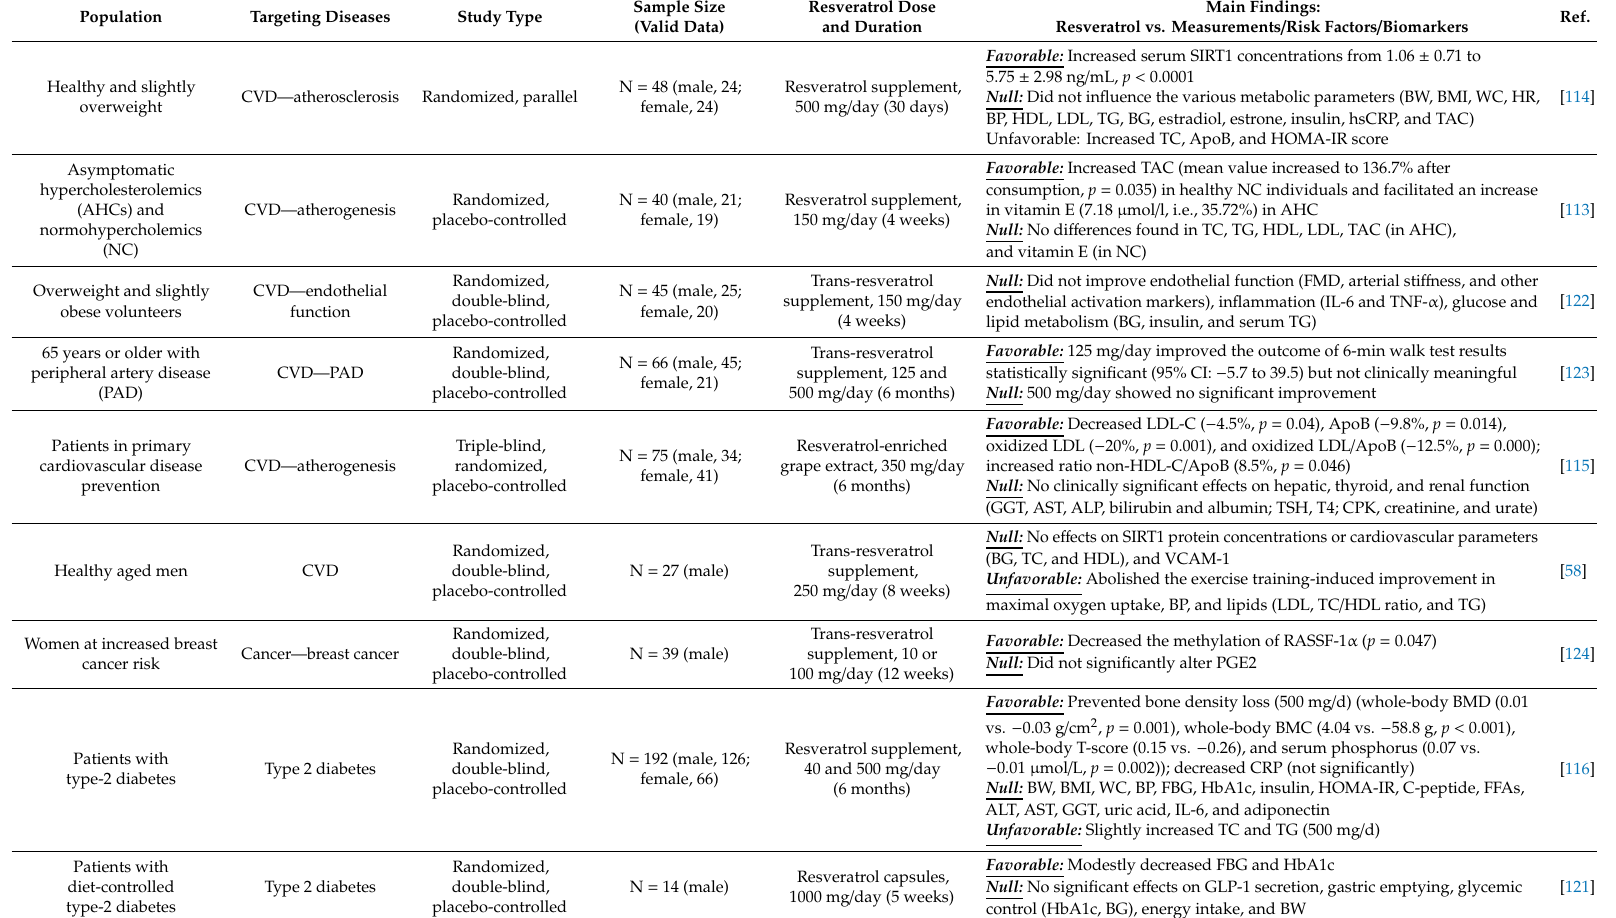
Table 3. The results of resveratrol from clinical